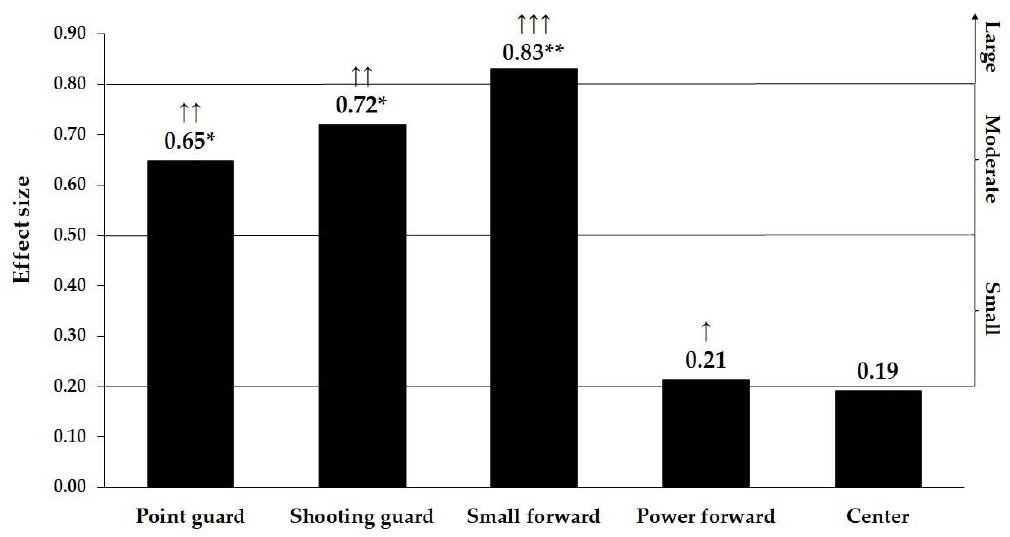
Figure 1. The size of the difference in body height between the teams of different ranking relative to position in team. * Significant at p < 0.05, ** Significant at p < 0.01, ↑ —small effect size, ↑↑ —moderate effect size, ↑↑↑ —large effect size.